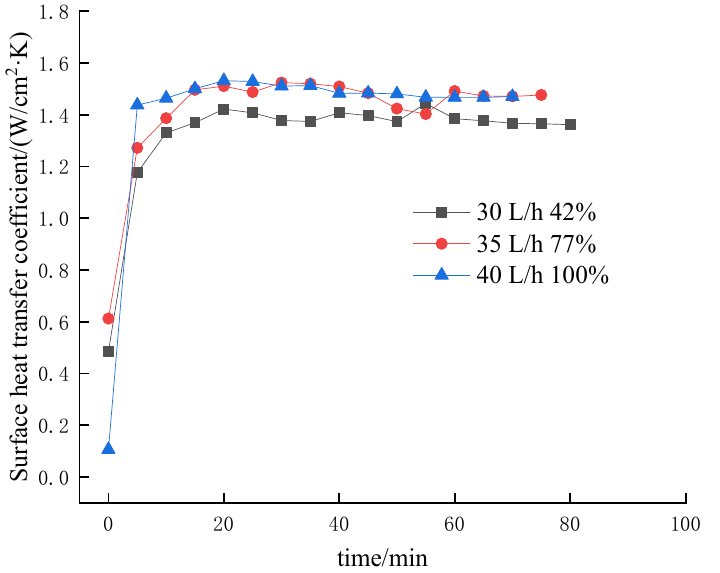
Figure 8. The influence of coverage rate of changing flow rate at 50 W/cm 2 on transient surface heat transfer coefficient.